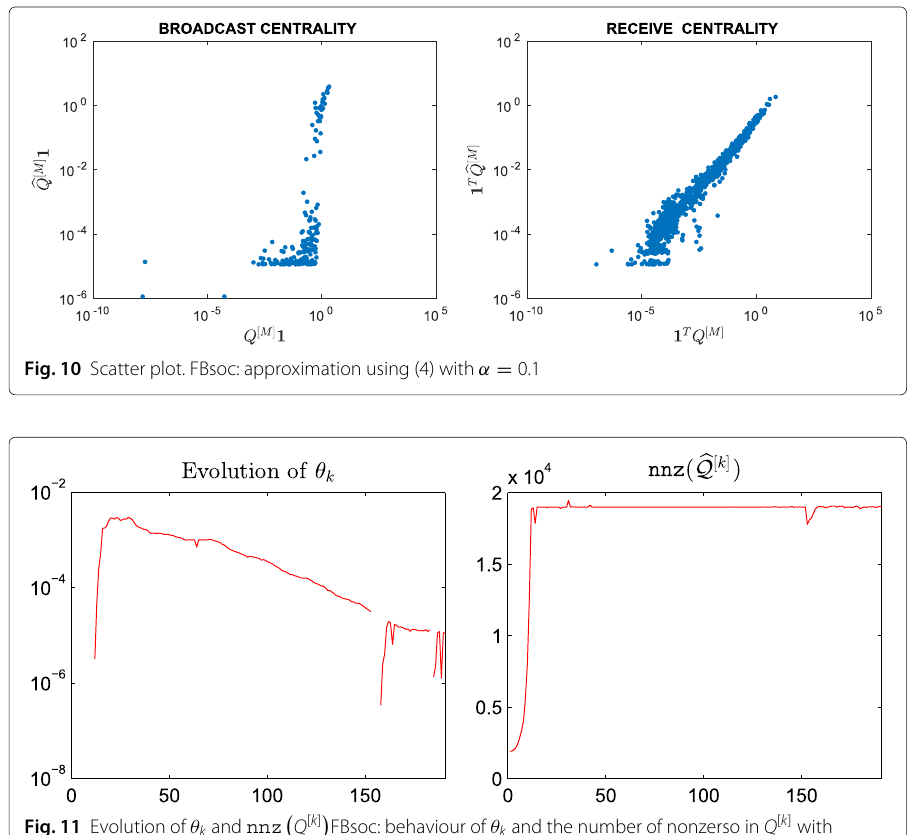
Fig. 11 Evolution of θ k and nnz respect to K , using α = 0.1